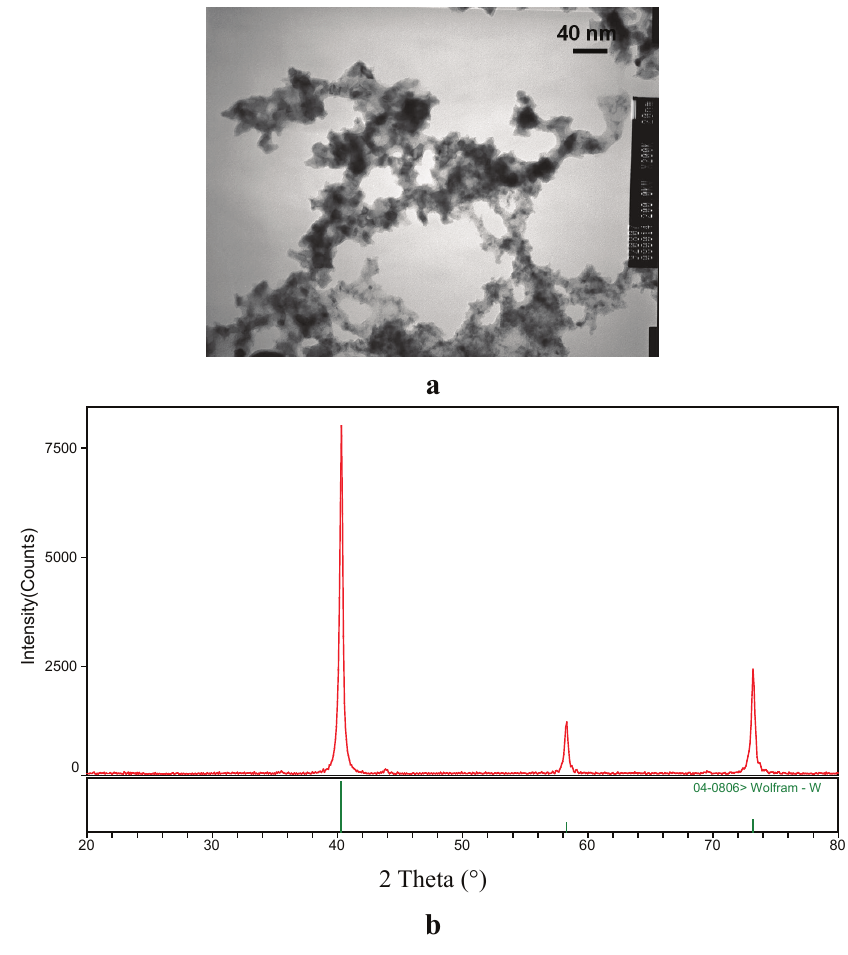
Figure 6. ( a ) Transmission electron micrograph of Tungsten nanopowders; ( b ) X-ray diffraction pattern of Tungsten